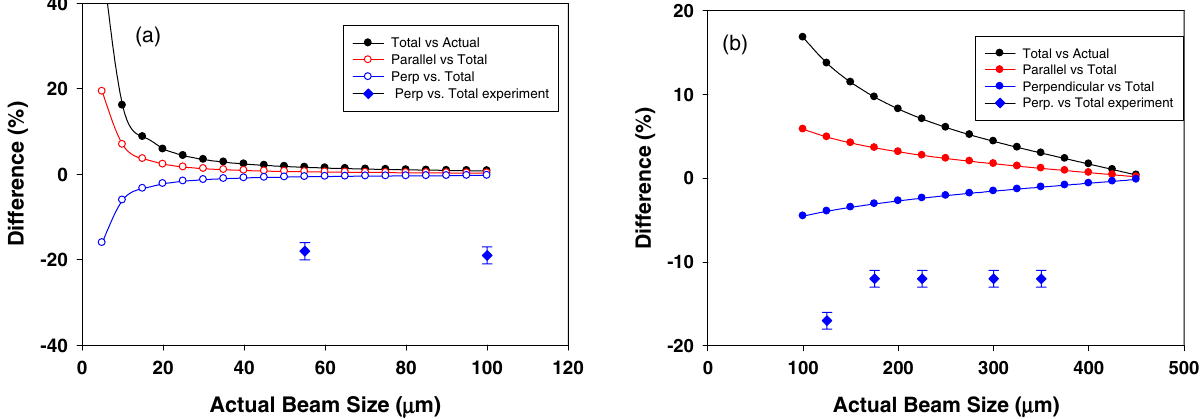
FIG. 13. Results of comparing the OTR PSF model component ratio results with different actual initial beam sizes for (a) 14.3-MeV case and (b) 4.5-GeV case. The experimental results for linear polarized orthogonal or perpendicular OTR vs the total OTR (diamonds) lie outside the model